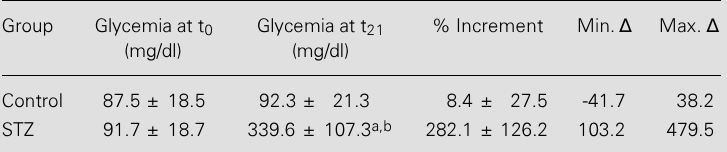
Table 1 - Blood glucose levels of control and STZ diabetic